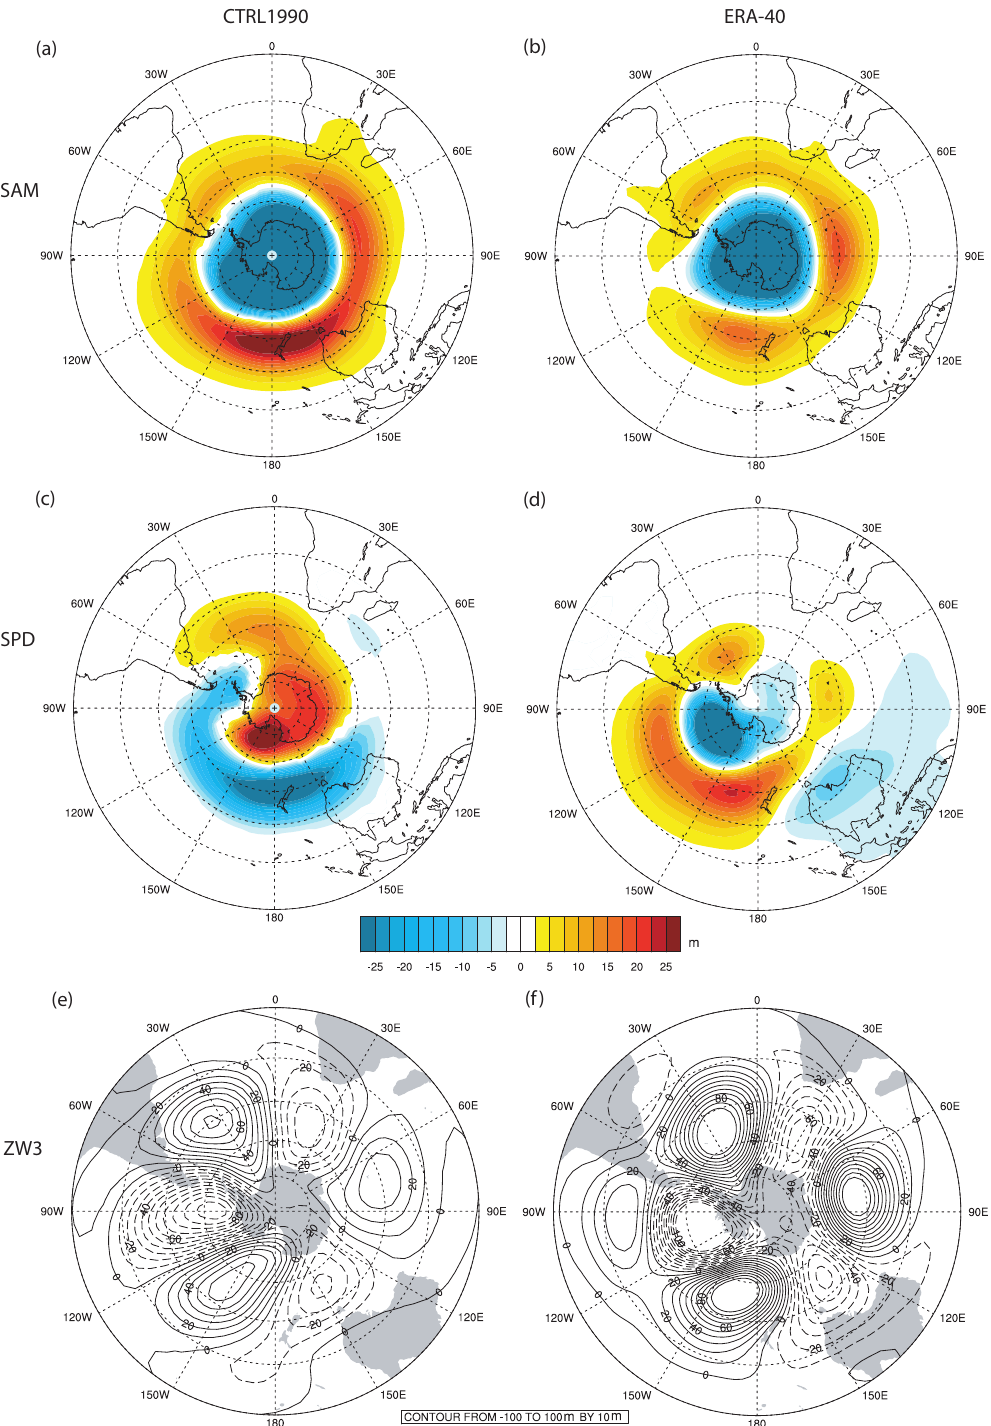
Fig. 2. Spatial patterns of (a) the SAM for the CTRL1990 simulation and (b) for ERA-40 reanalysis data; (c) the SPD for the CTRL1990 simulation and (d) for ERA-40 reanalysis; (e) the ZW3 for the CTRL1990 simulation and (f) for ERA-40 reanalysis. (a) to (d) are shown as a regression of the time series of the respective mode onto the Z850hPa field. Units are m per standard deviation change of the index. Only values significant at the 95% level have been coloured. (e) and (f) show the composite of the spatial anomalies of +/- 1 standard deviations of the ZW3 index.